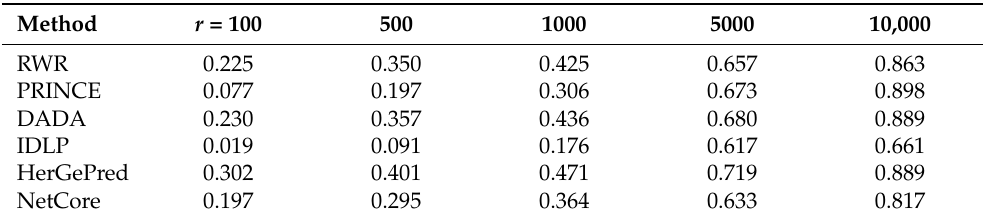
Table 4. Recall values evaluated by gene ranks for disease-gene association prediction with known disease genes from sample-1.